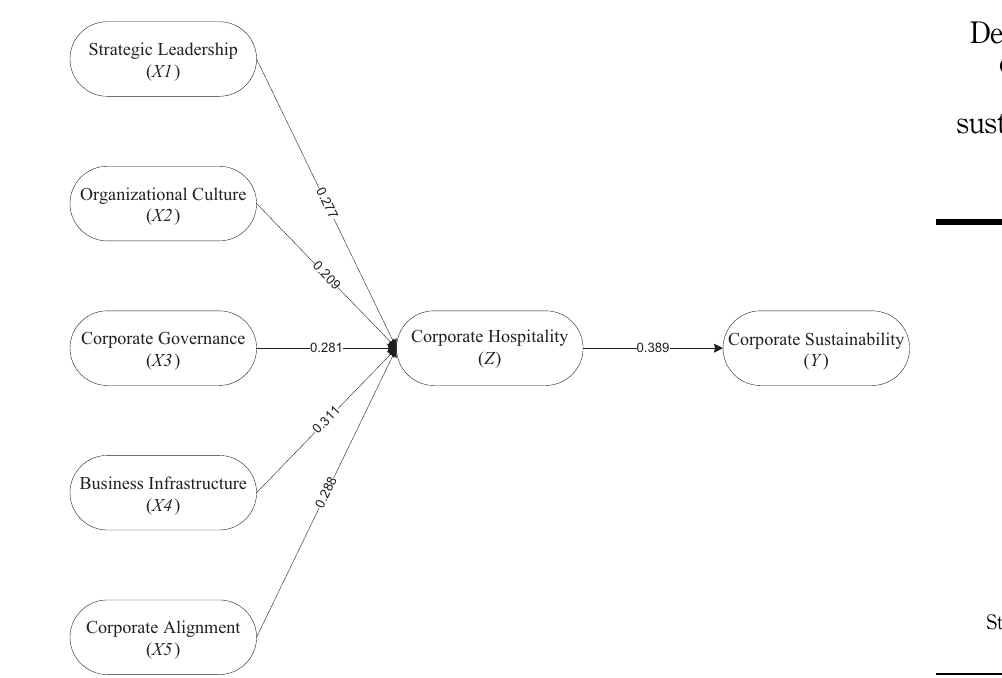
Figure 2. Structural model